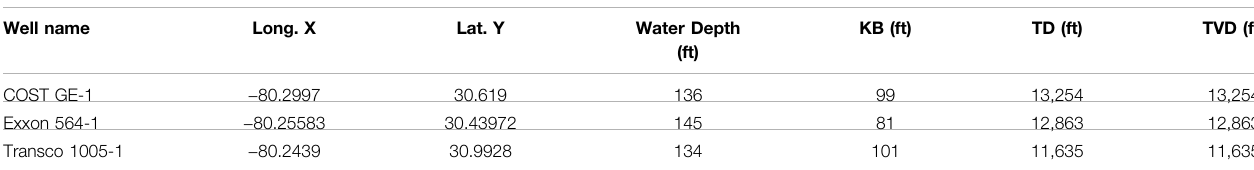
TABLE 1 | Wells used for acoustic impedance inversions and formation